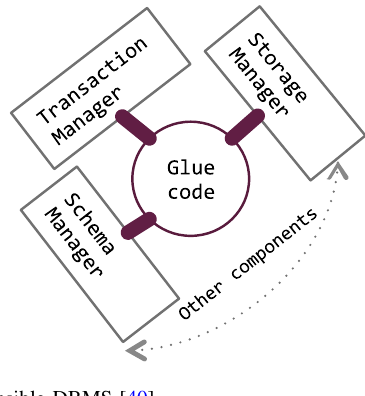
Fig. 6 Extensible